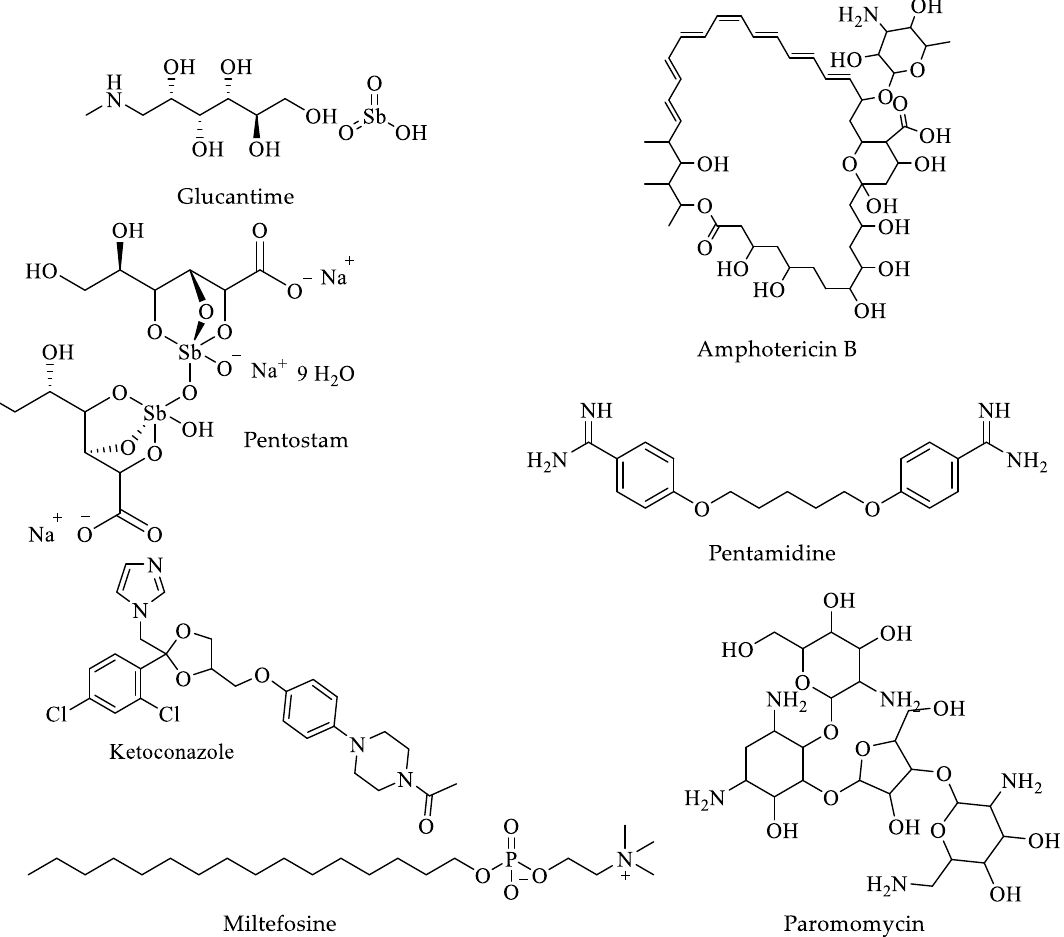
Figure 6. Drugs used for the pharmacological treatment of Leishmaniasis.